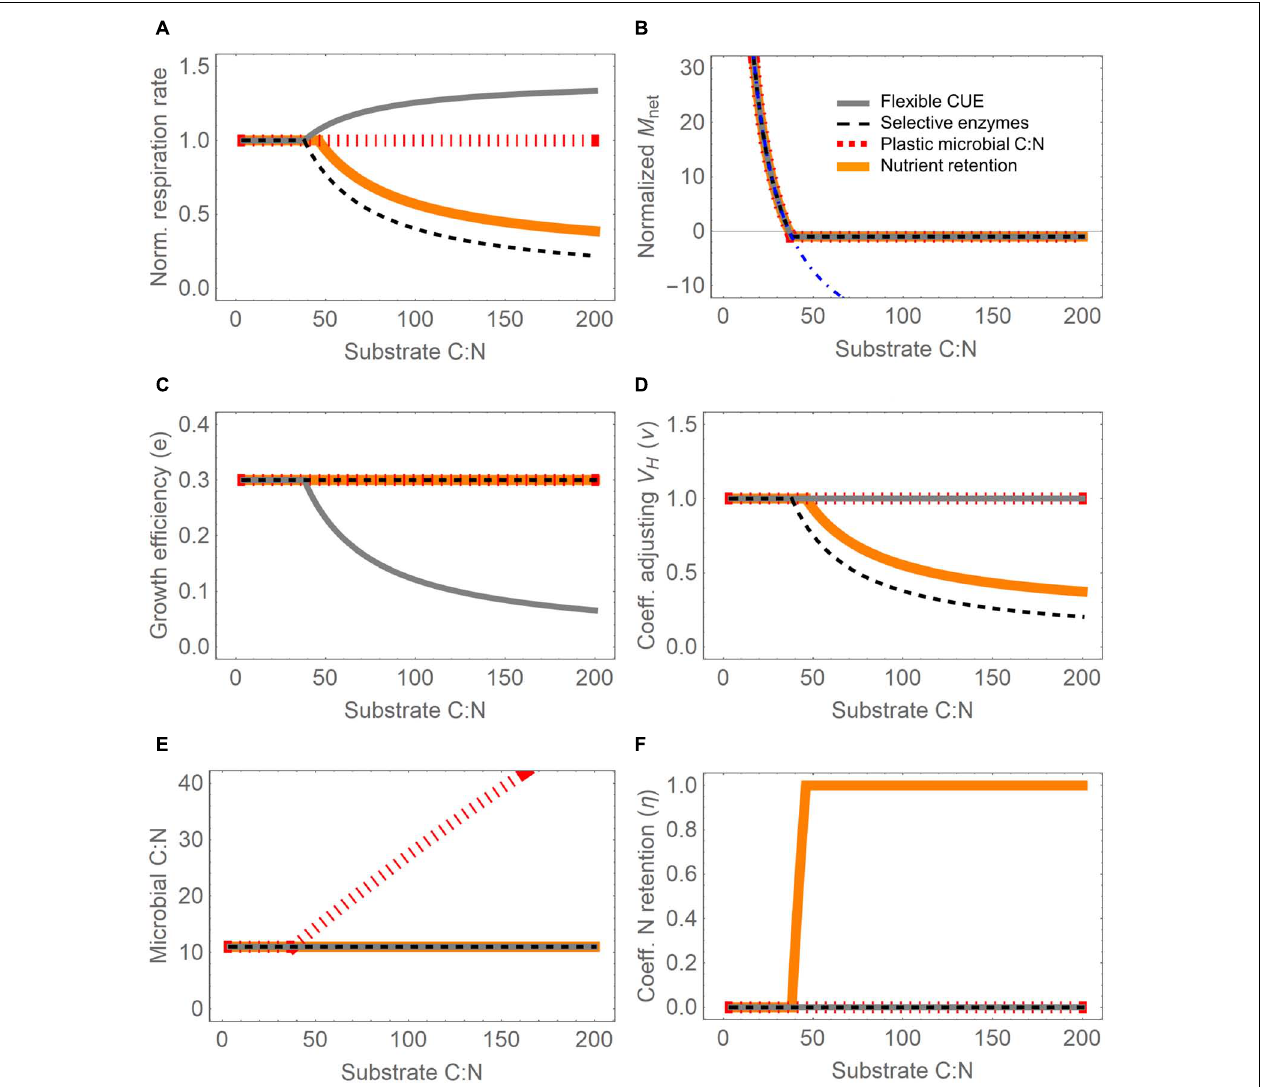
FIGURE 2 | Effect of four resource use modes (different line styles) for varying substrate C:N ratio on: (A) total microbial respiration rate (normalized by the C-limited respiration rate), (B) net N mineralization rate, M net (normalized by the maximum immobilization rate, I max ), (C) growth efficiency (Eq. 22), (D) coefficient adjusting C H decomposition rate, ν (Eq. 23), (E) microbial biomass C:N ratio at equilibrium (obtained by combining Eqs 4, 15), and (F) N retention efficiency, η (Eq. 25). Variations in substrate C:N are imposed by increasing the fraction of carbohydrates from 2 to 98% (lowest and highest C:N on the abscissa, respectively), assuming no oxidizable compounds are present; microbial biomass C is fixed to 1% of the total organic C. In panel (B) , the dot-dashed blue curve shows the net N mineralization rate under C limitation. Parameter values are reported in Table 3 , except for e max = 0.3, I max = 0.004 gN (g initial C) − 1 y − 1 , V H = 4 y − 1 , and M = 0.2 g C (g